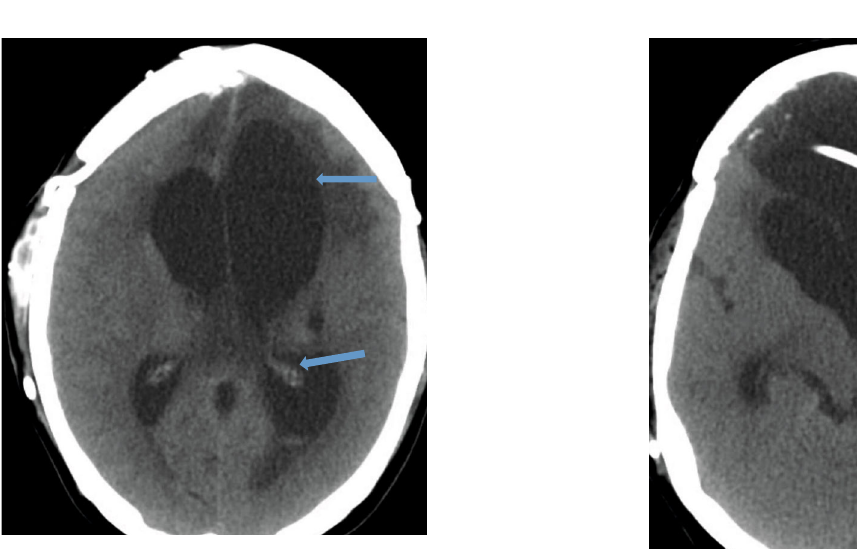
Figure 2: CT head showing moderate enlargement of the ventricular system with left-sided intraventricular hemorrhage (blue arrows). Figure 3: CT head showing preexisting VP shunt (blue